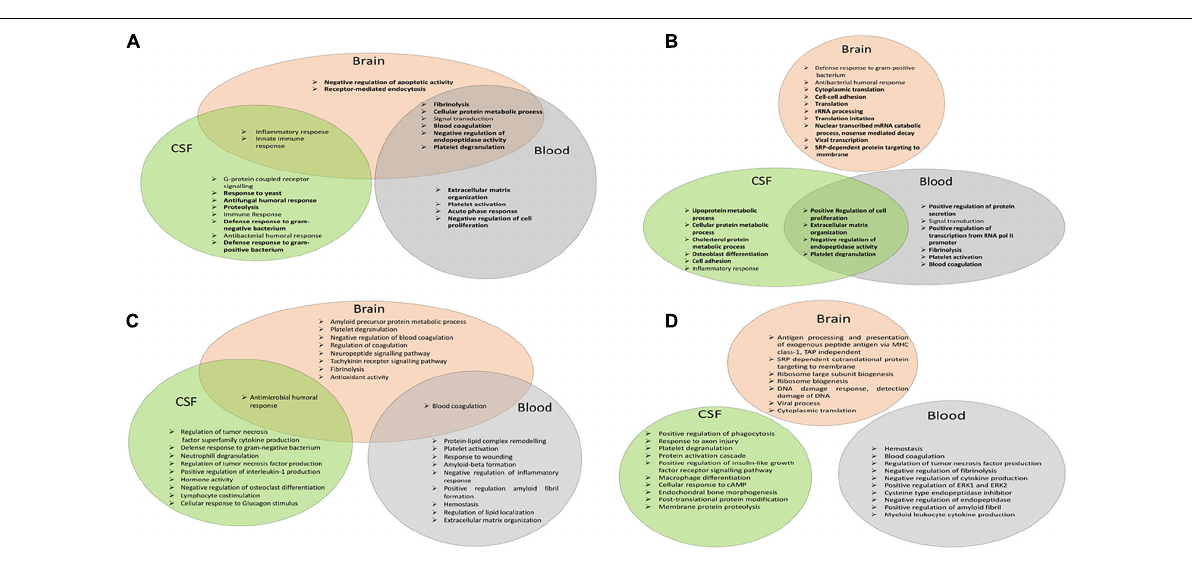
process, endocytosis, and negative regulation of